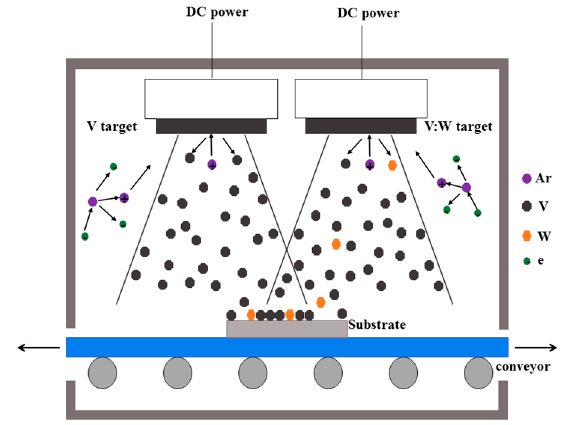
Figure 1. Schematic diagram of fabricating W-doped V thin films with the dual-target co-sputtering method. A pure and a W-doped V targets were used in the co-sputtering procedure. The resultant co-sputtered thin film was oxidation annealed by controlling the oxygen pressure to form the W-doped VO 2 thin film.